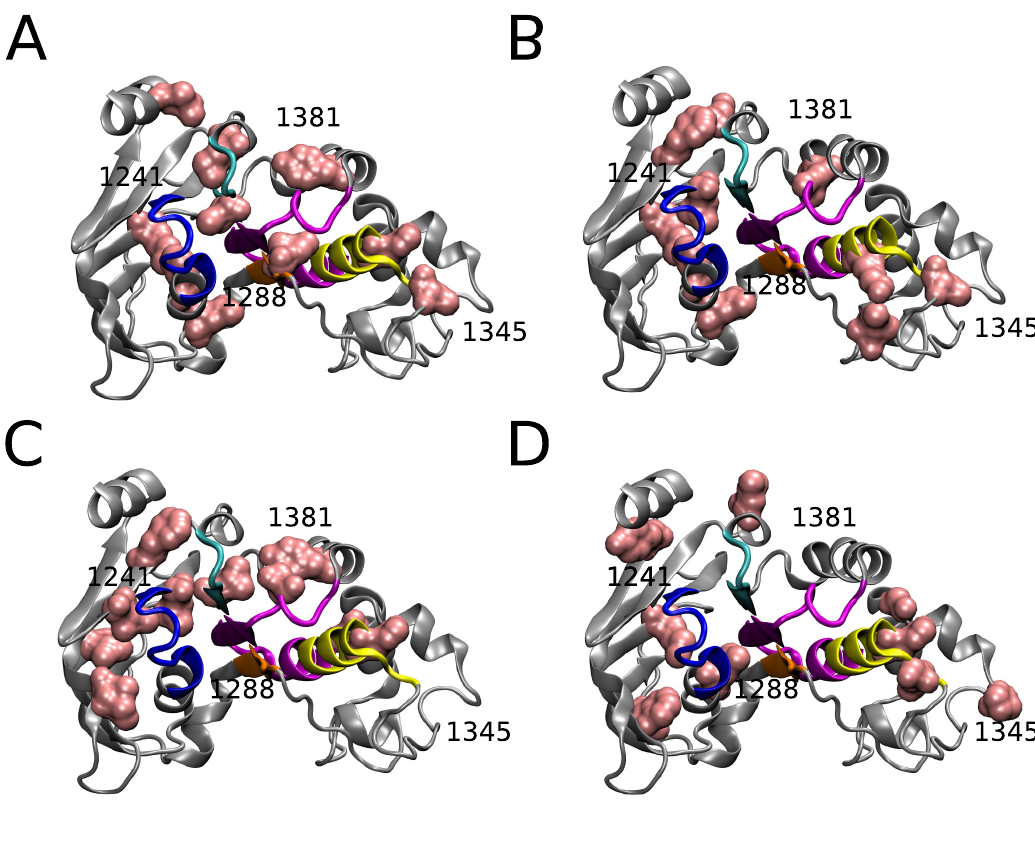
Fig 10. Predicted stabilizing mutations to restore residue coupling in NBD2. Cryo-EM Structure of NBD2 residues 1207–1436 (PDB:5UAK) with predicted stabilizing mutations (see Materials and Methods) colored in pink for (A) S1251T perturbation (B)